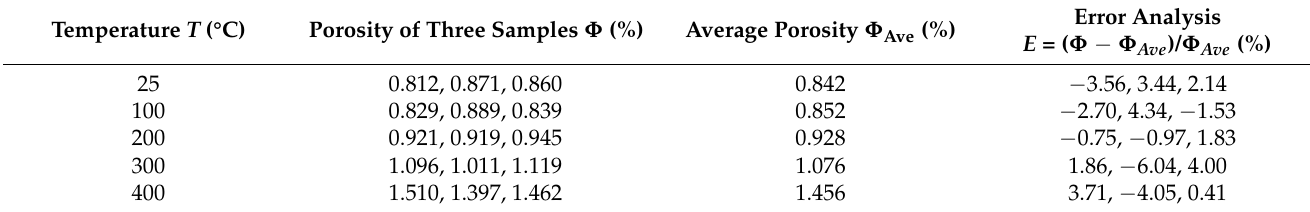
Table 2. Porosity of granite at different temperatures.